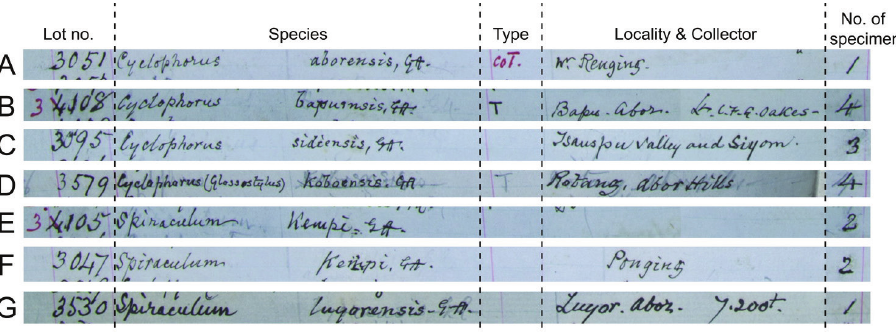
Figure 7. Record in the NHM Register of Godwin-Austen Collection in Godwin-Austen’s handwriting of A No. 3051 Cyclophorus aborensis B No. 3108 Cyclophorus ( Glossostylus ) bapuensis C No. 3095 Cyclo- phorus ( Glossostylus ) sidiensis D No. 3579 Cyclophorus ( Glossostylus ) koboensis E No. 3105 Spiraculum kempi F No. 3047 Spiraculum kempi , and G No. 3530 Spiraculum luyorensis